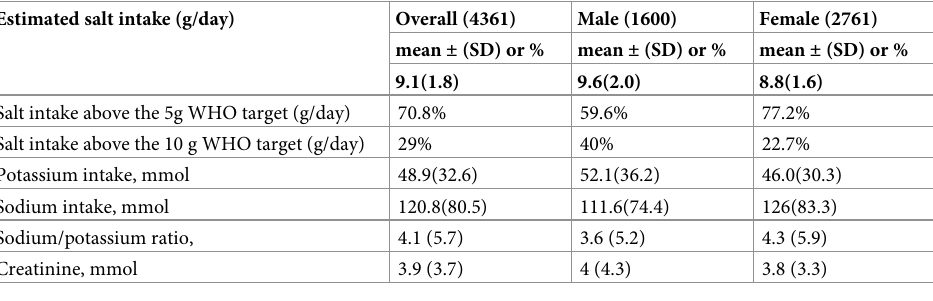
Table 2. Weighted results for salt intake, potassium intake, and sodium/potassium